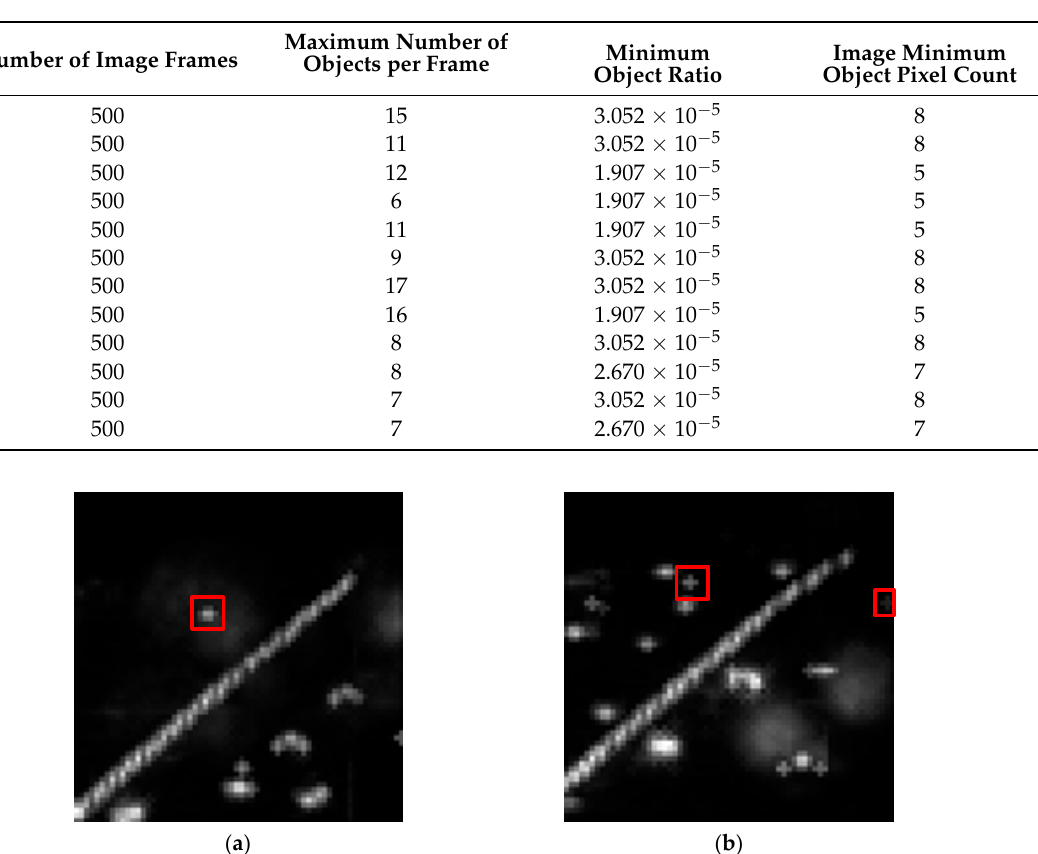
Table 1. Night vehicle data details.